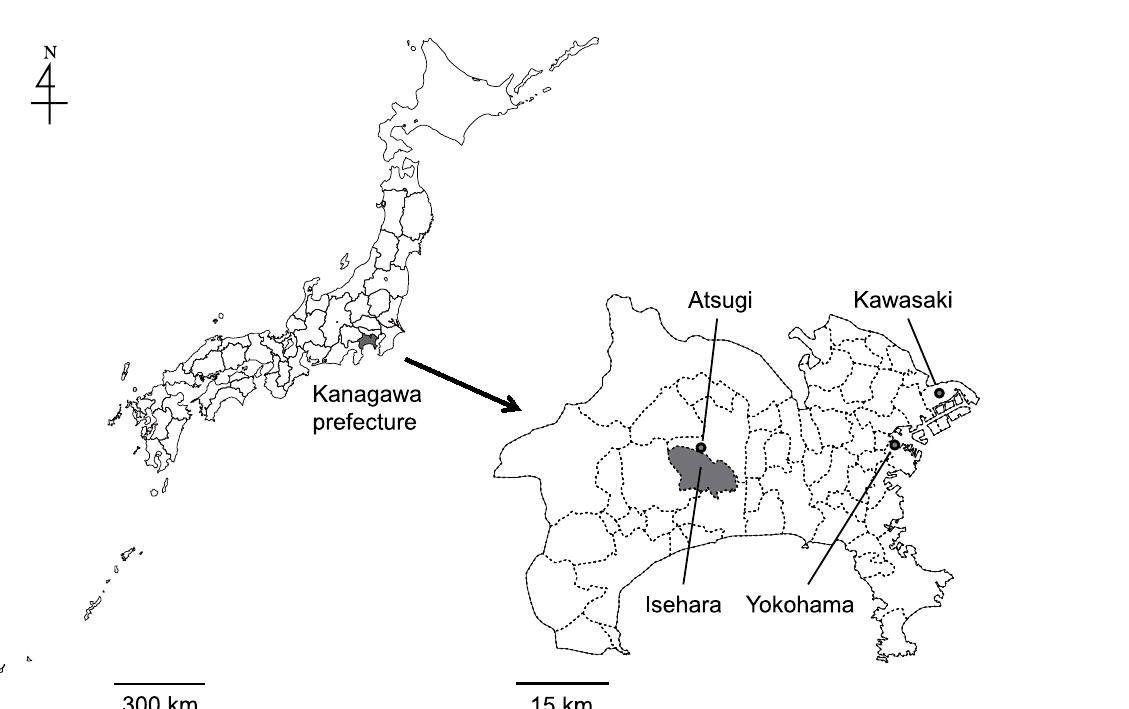
Fig 1. Sampling and monitoring locations. Location of Isehara city, where the indoor, outdoor, and personal pollen sampling was undertaken for study subjects (filled with grey), and the stationary monitoring stations of the Japanese government